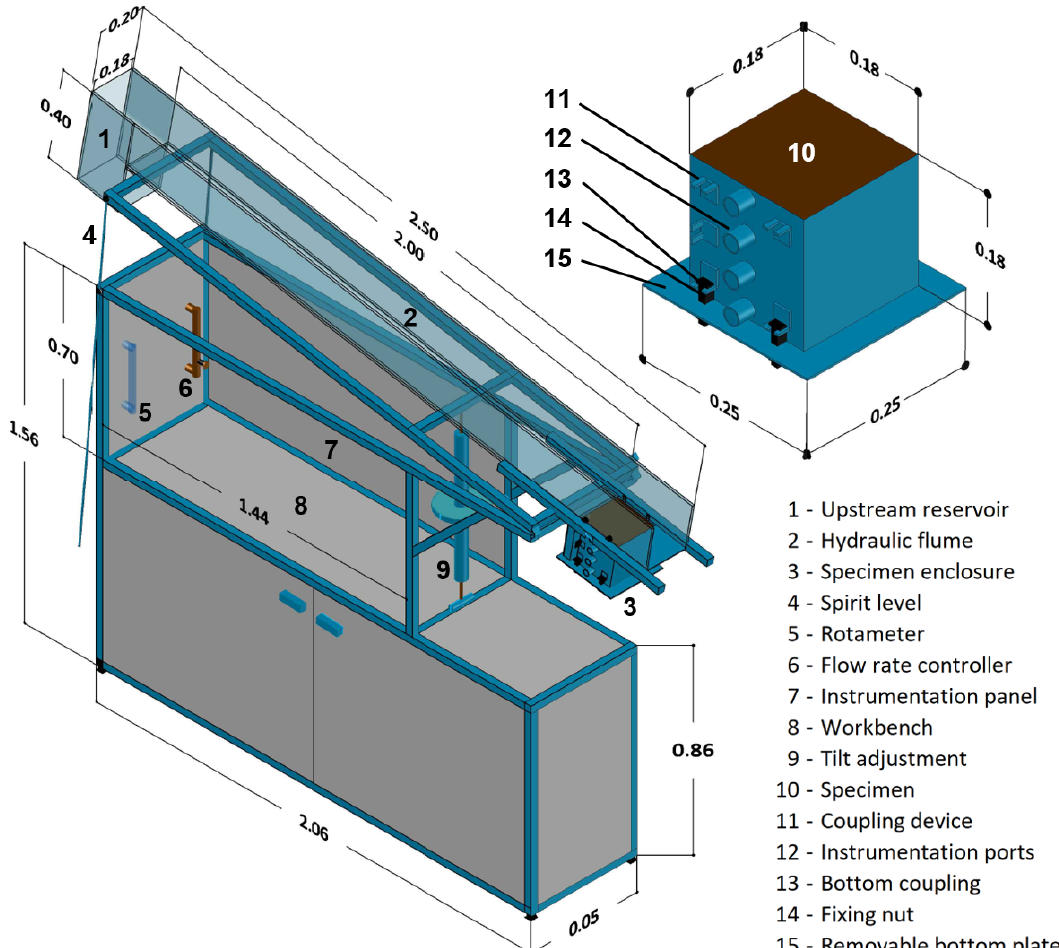
Figure 2. Flume apparatus; all dimensions are in meters.